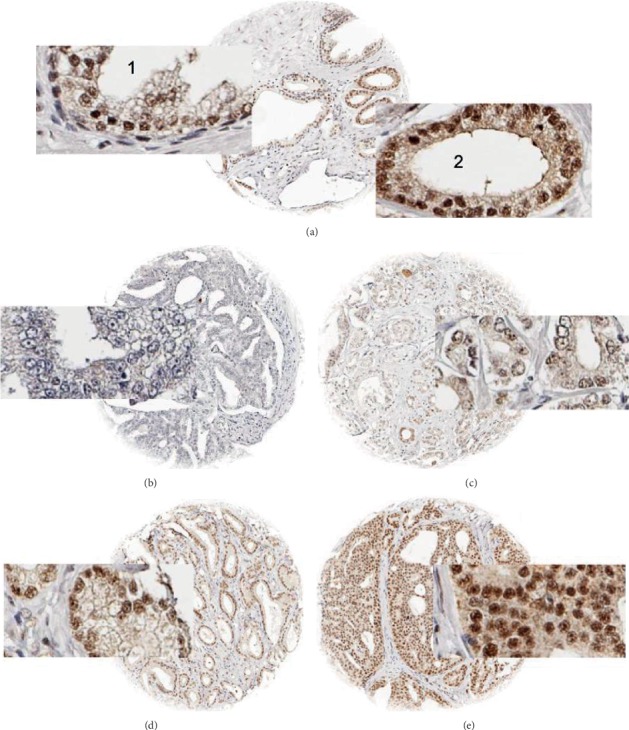
Examples of PNUTS staining: (a) comparison of PNUTS staining in (1) normal and (2) cancerous prostate glands of the same TMA spot. Cancer spots with (b) lack of staining and (c) weak, (d) moderate, and (e) strong staining.